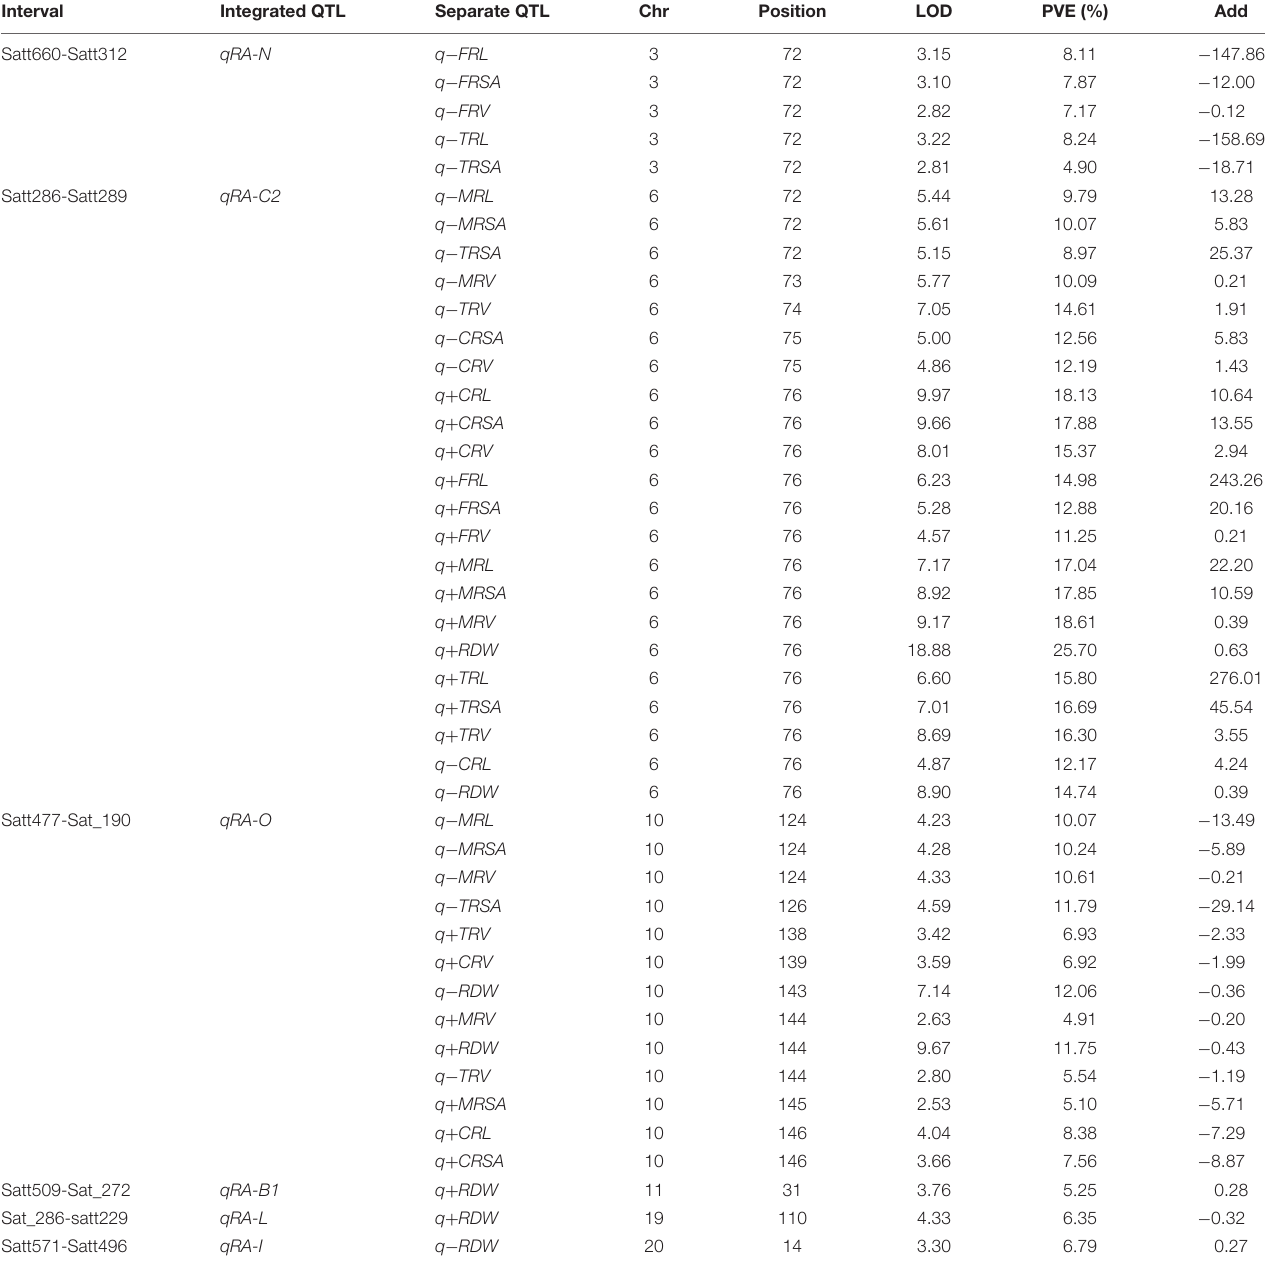
TABLE 2 | Putative QTLs detected for RA traits using 175 F 9 : 11 soybean RILs in the field. Interval Integrated QTL Separate QTL Chr Position LOD PVE (%) Add Satt660-Satt312 qRA-N q − FRL